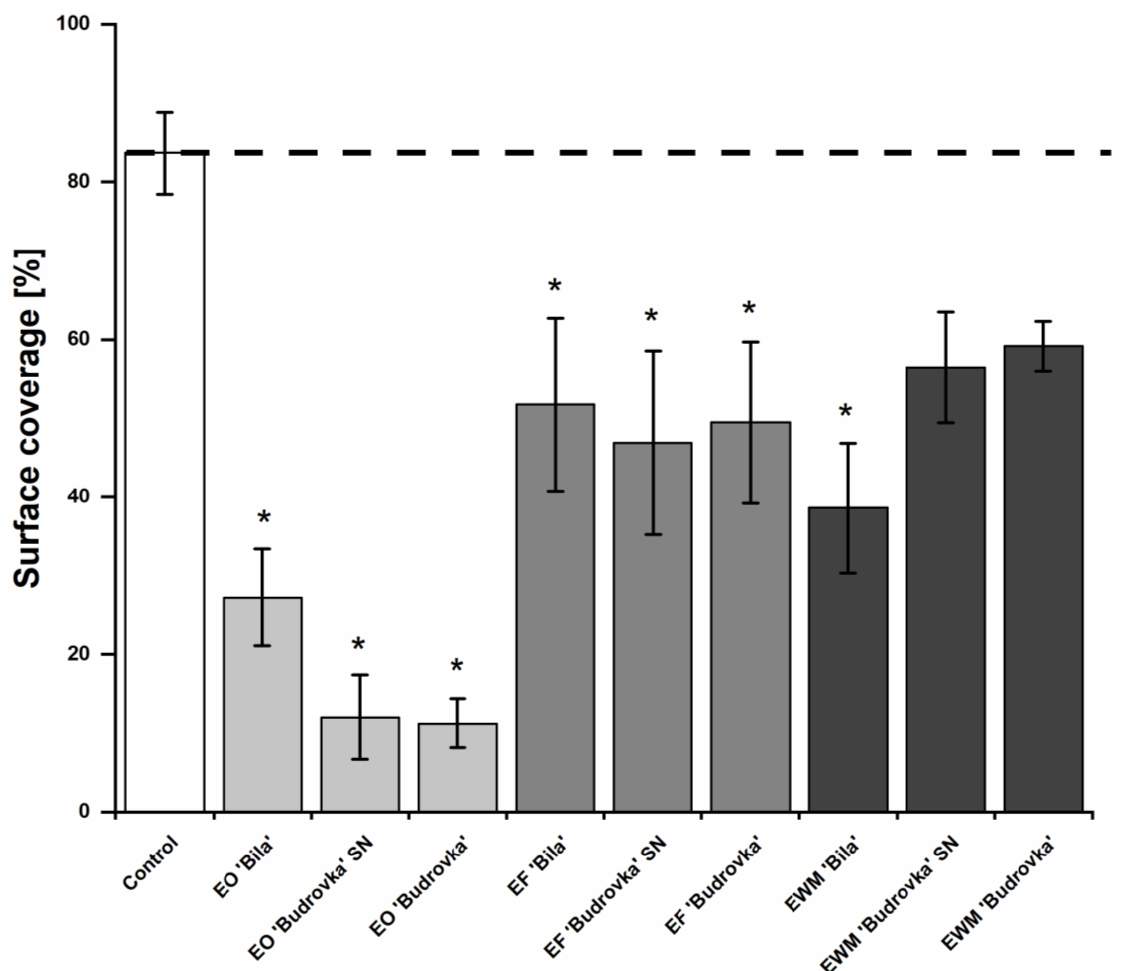
Figure 3. Effect of different lavandin formulations (EOs, EFs and EWMs) at subinhibitory concen- tration (0.25 × MIC) on biofilm formation of C. jejuni NCTC 11168. C. jejuni NCTC 11,168 was cultivated on a glass surface without or with the addition of lavandin formulations at subinhibitory concentration in a micro-aerobic atmosphere at 42 °C for 72 h. Every 24 h, the SM was replaced with a fresh Muller–Hinton (MH) broth, where lavandin formulations at subinhibitory concentration were added. After 72 h of incubation, microscopic slides were rinsed and stained with 1% [ v / v ] crystal violet. Biofilms were examined at air/liquid interface and surface coverage was measured. Average values ± SD are shown. * p < 0.05, vs. control. (EO, essential oil; EF, ethanolic extract prior to distillation; EWM, ethanolic extract of post-distillation waste